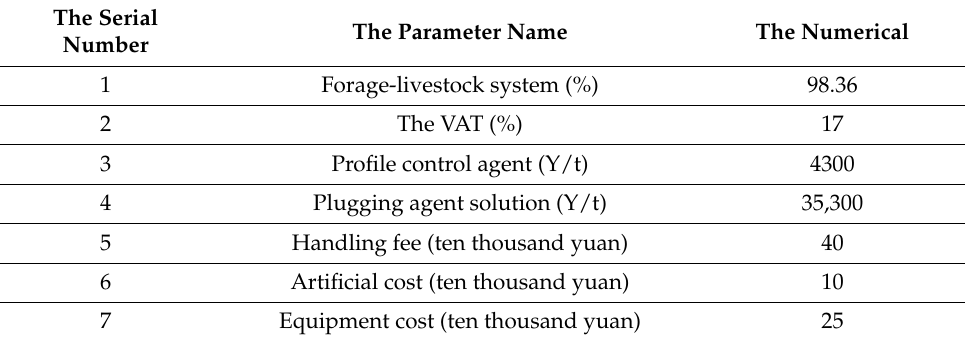
Table 11. Details of pharmaceutical and construction